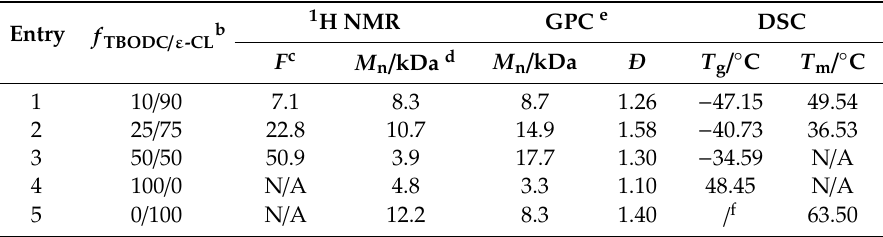
Table 1. Ring opening polymerization of TBODC and ε - caprolactone (CL) catalyzed by SnOct 2 a .